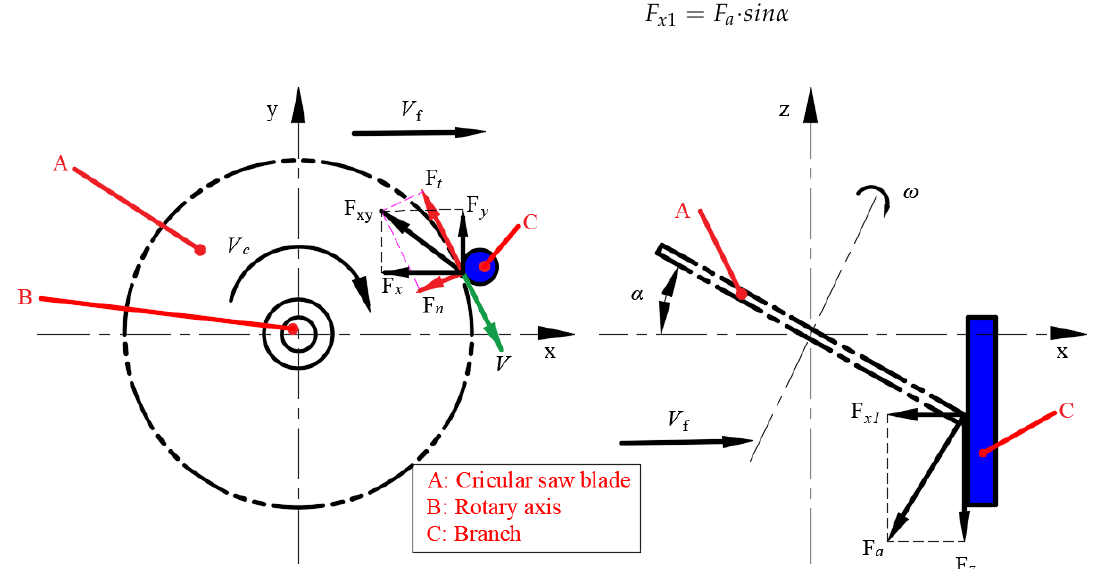
Figure 4. Diagram of cutting forces on saw blades.